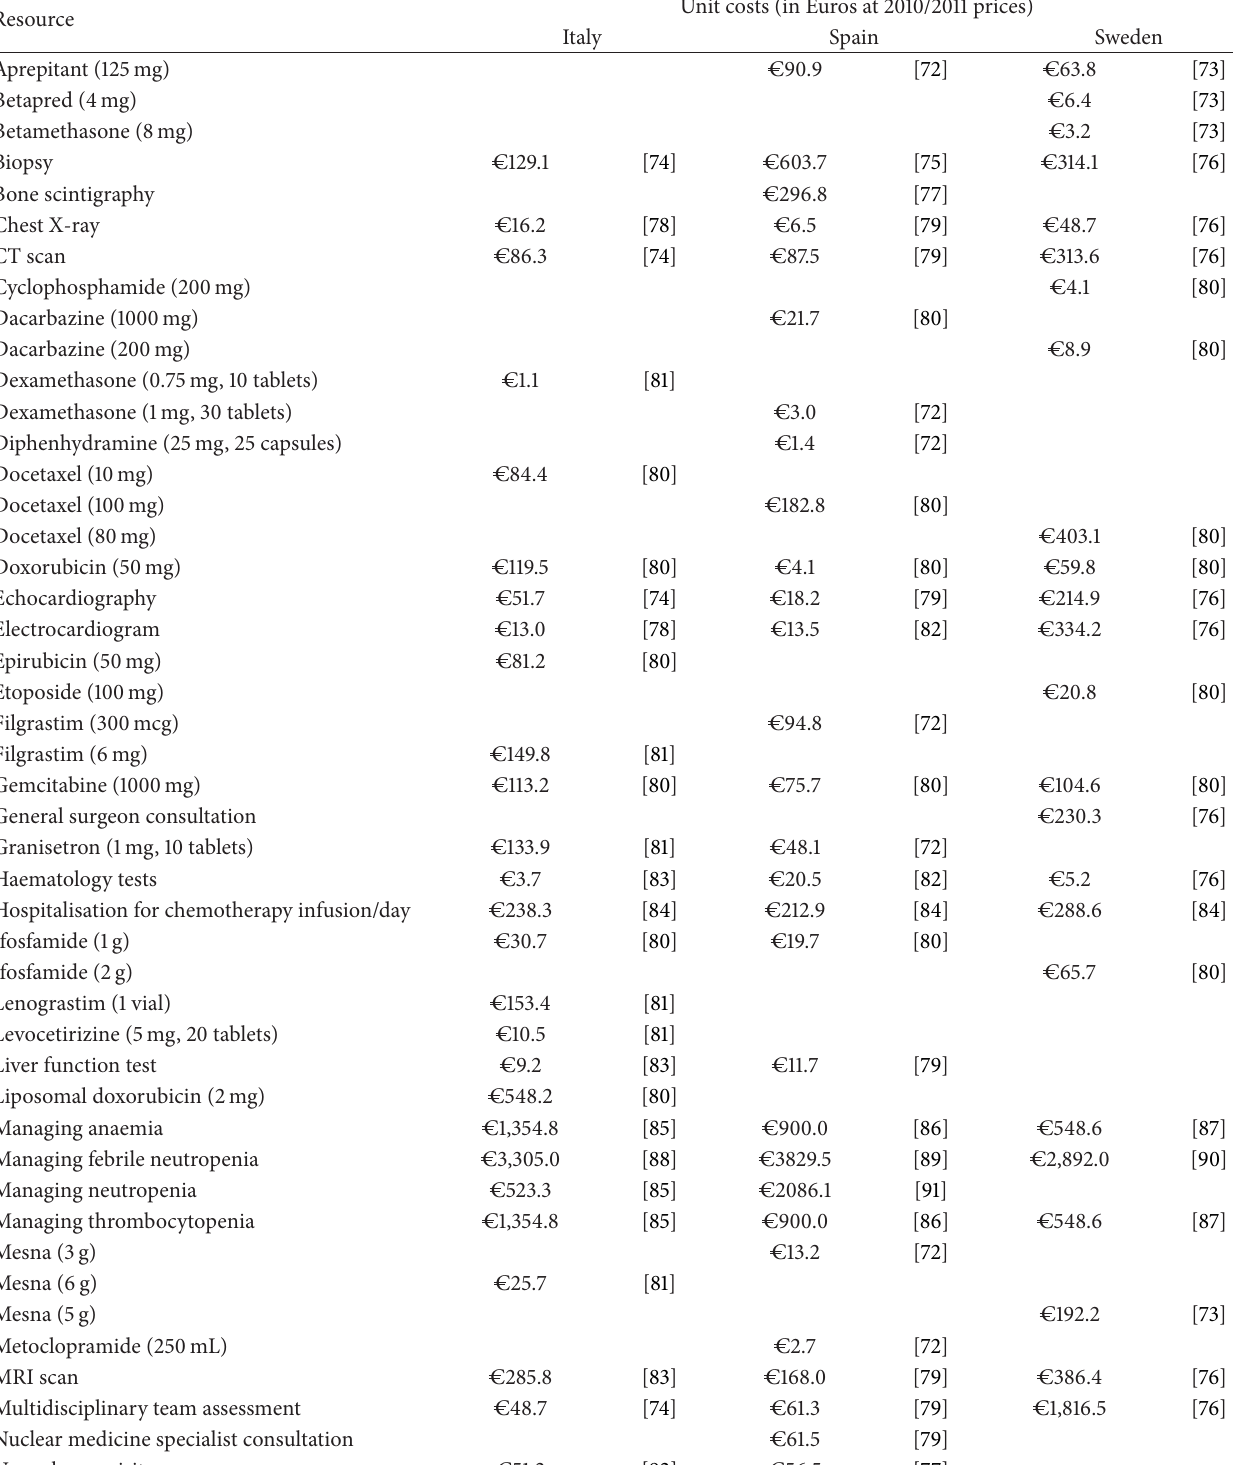
Table 5: Unit resource costs (in Euros at 2010/2011 prices) used in the